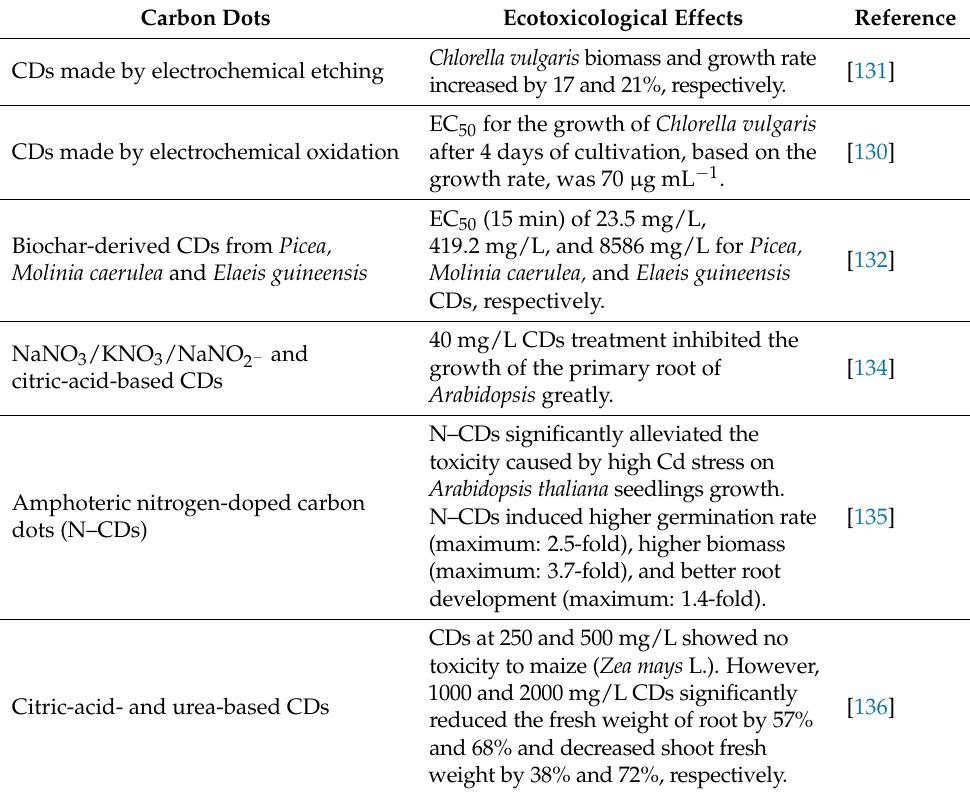
Table 3. Ecotoxicity of carbon